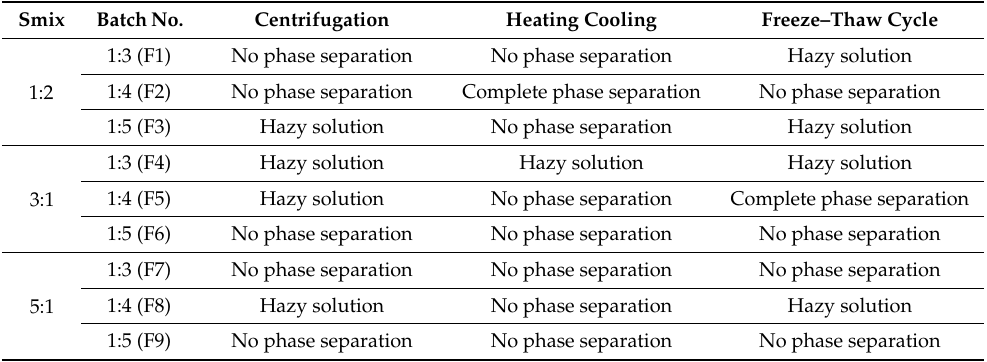
Table 4. Dispersion Stability of